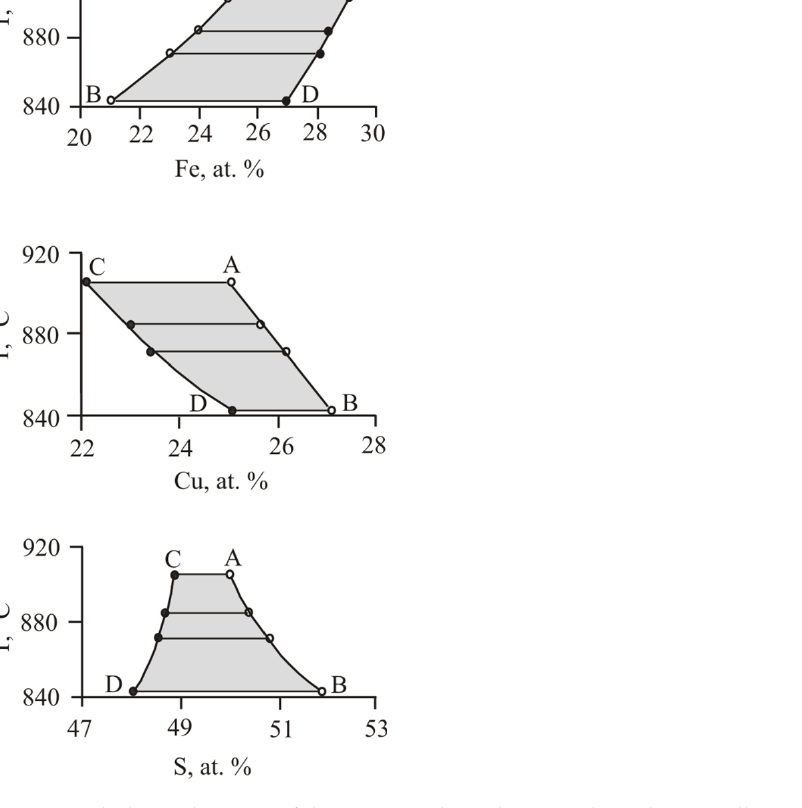
Figure 4. Polythermal section of the Cu-Fe-S phase diagram along the crystallization path in the Iss crystallization region. AB is liquidus line, and CD is solidus line.